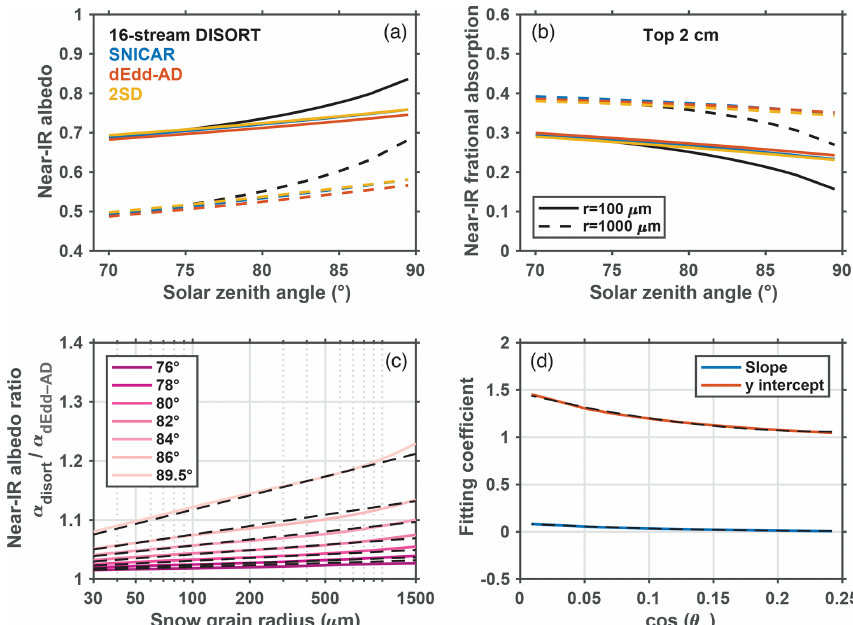
Figure 11. (a) Direct near-IR snow albedo and (b) near-IR fractional absorption by top 2cm snow of a 2m thick snowpack, for solar zenith angles larger than 70 ◦ and snow grain radii of 100 and 1000µm. (c) The ratios of near-IR albedo computed using dEdd–AD compared to those computed using 16-stream DISORT for different solar zenith angles. These ratios are parameterized as linear functions of the logarithmic of snow grain radius. The slopes and y intercepts are shown in (d) . The black dashed curves in (c, d ) are fitting values computed using parameterization discussed in Sect.